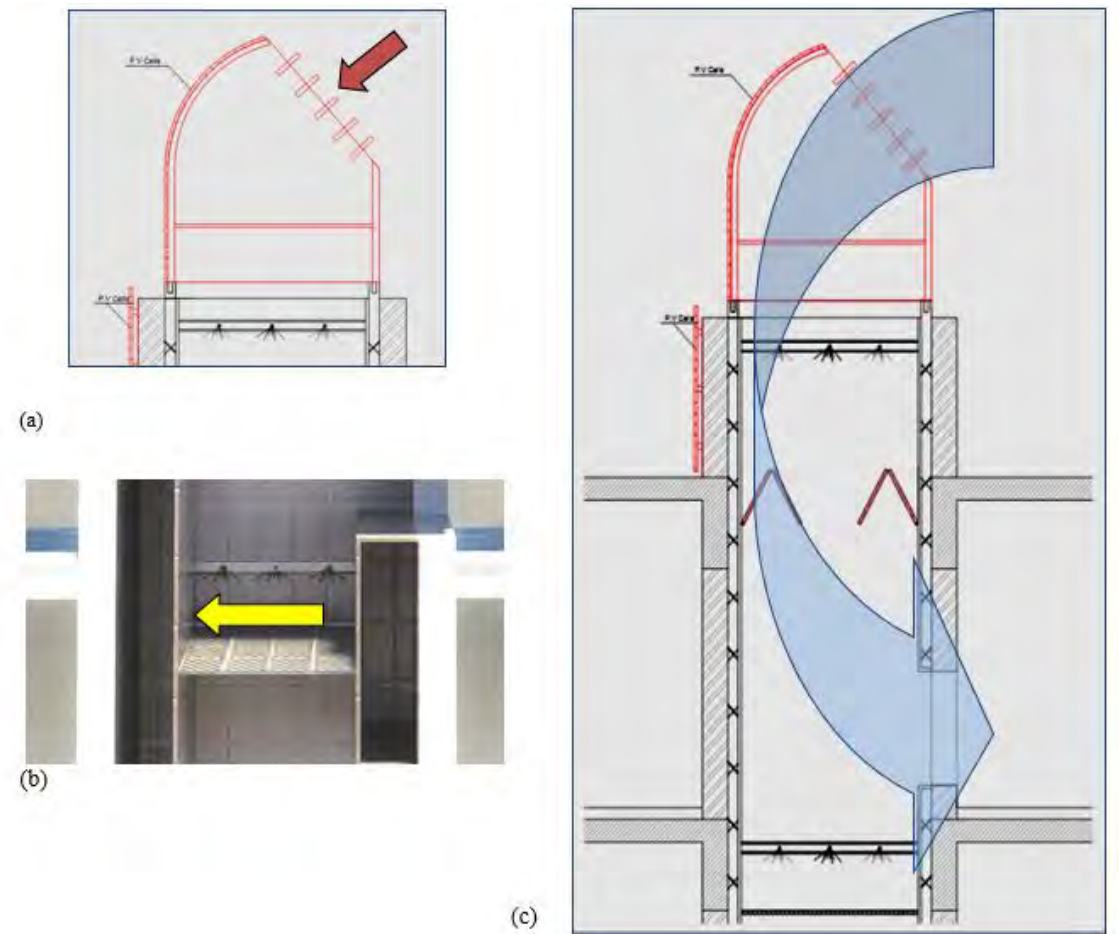
Figure 6. (a) The electronic smart Malqaff(Mohamed,2012) (b) The moving sides of theelectronic Malqaff (Mohamed,2012) (c) Section of the electronic Malqaff(Mohamed,2012)